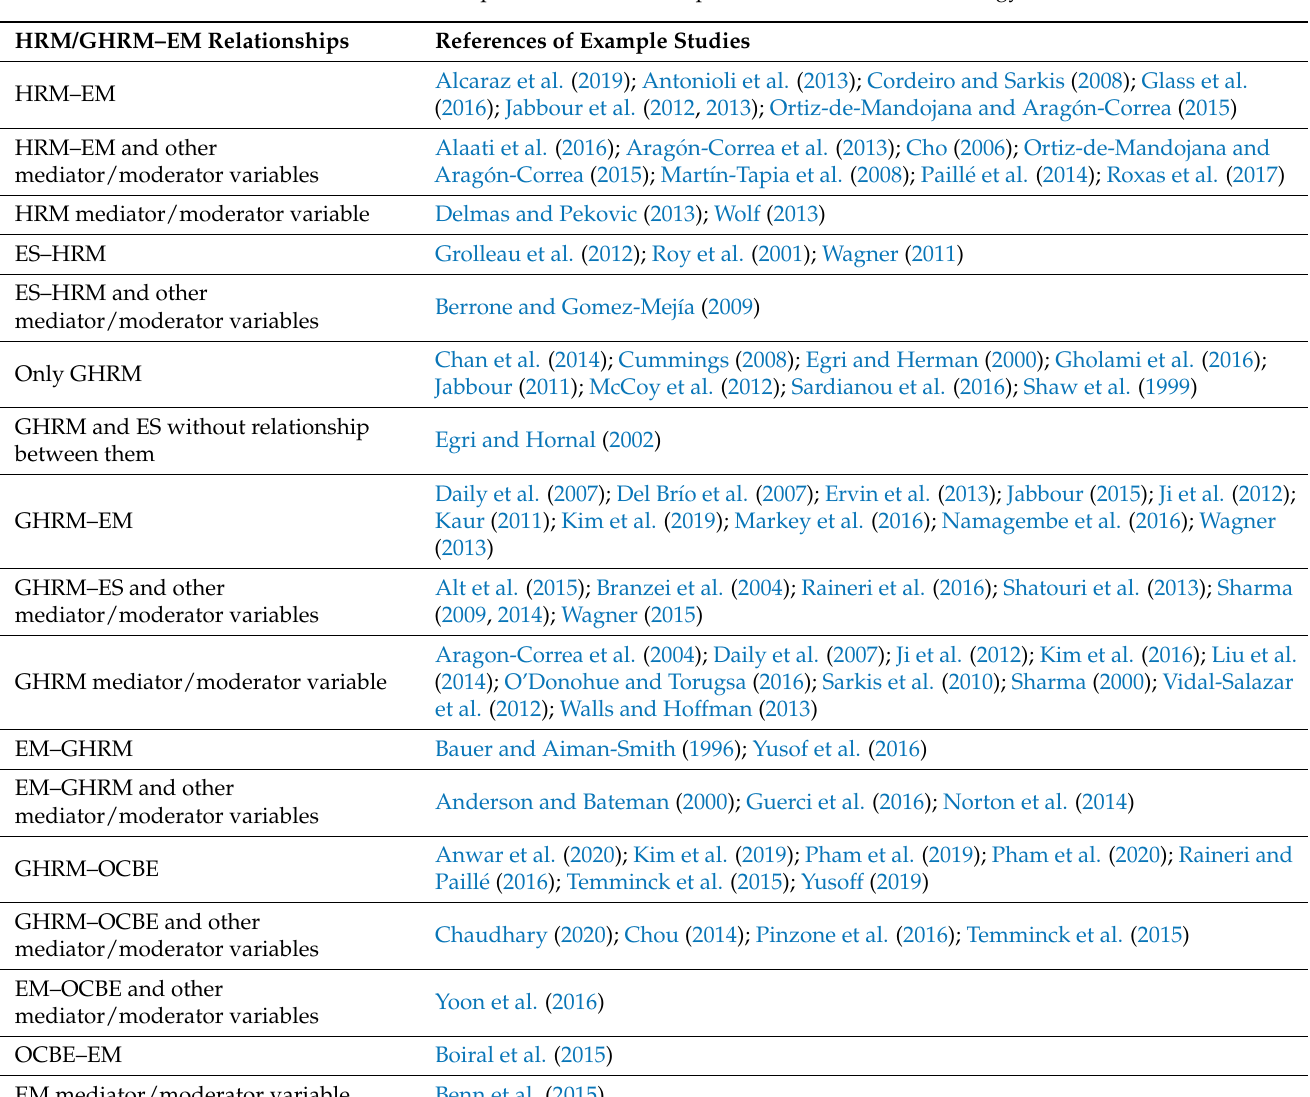
Table 1. Relationships between human capital and environmental